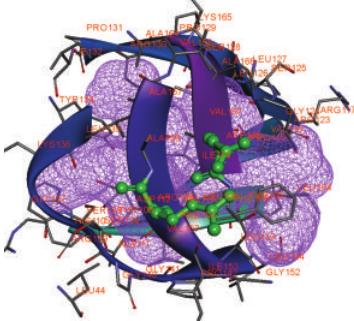
Figure 3: Active site of target protein with mutant structure shown in ball-and-stick model of variants R155K and D168A (violet wire mesh indicates binding cavity in the active